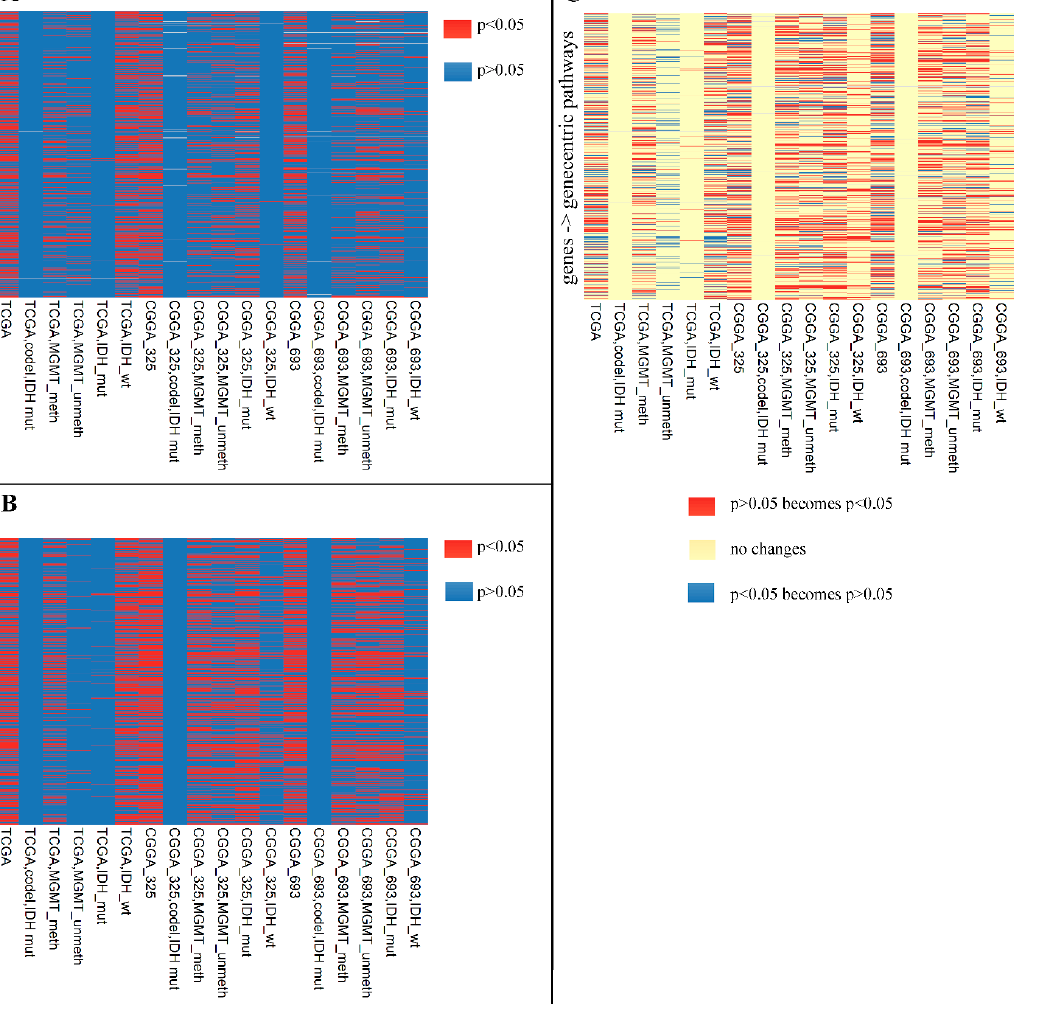
Figure 10. Adjusted log-rank test p -values for ( A ) 6467 individual genes as OS biomarkers in LGG and its subtypes; ( B ) 6467 gene-centric pathways as OS biomarkers in LGG and its subtypes. ( C ) Comparison of log rank test adjusted p -values when comparing a gene as the OS biomarker and the corresponding gene-centric pathway as the OS biomarker; here red bands mean better performance of pathways, and blue bands mean better performance of single-gene